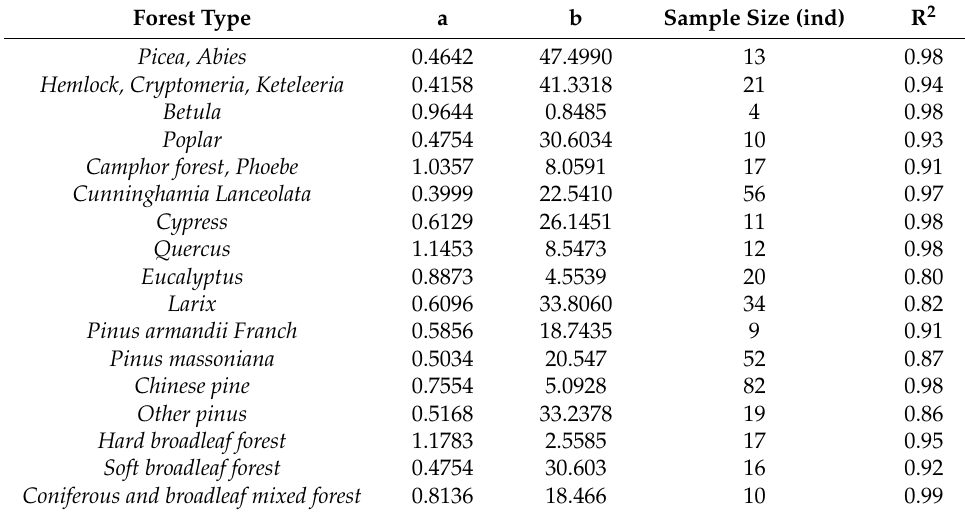
Table 1. Parameters a and b for calculating forest aboveground biomass